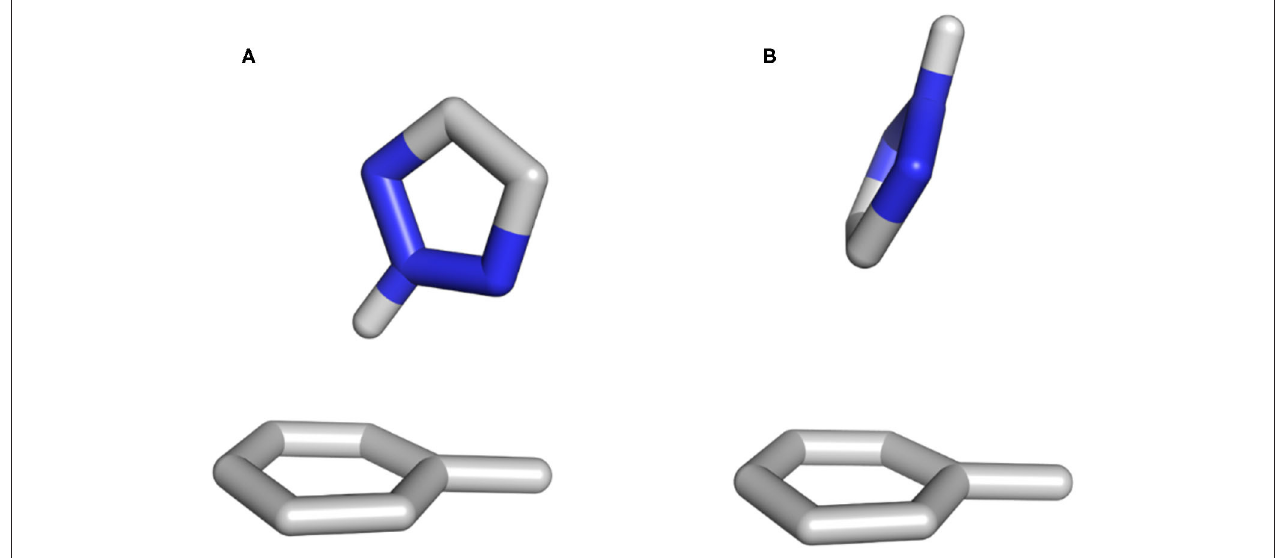
FIGURE 8 | Two different T-stacked conformations identified in the simulations using explicit solvent. The geometry shown in (A) can also be found in the vacuum simulations. The conformation in (B) however, can only be sampled when using explicit solvation, as it needs to be stabilized by the surrounding water molecules.